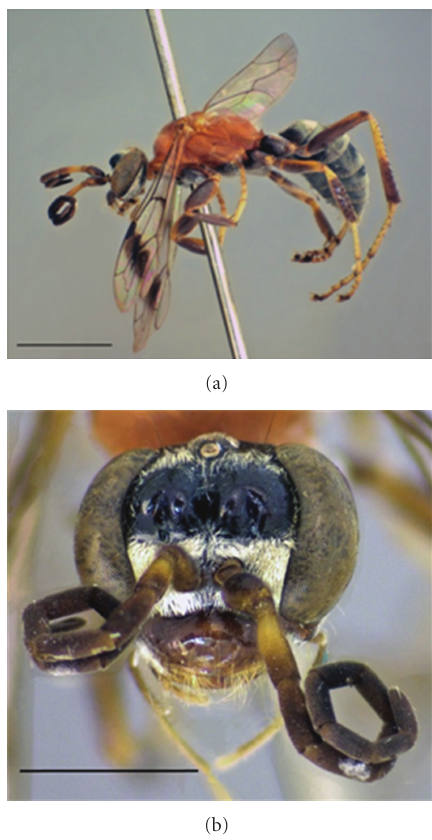
Figure 1: Neotype of Ageniella ( Neotumagenia ) amazonica . (a) Habitus, lateral view. Scale = 2.4 mm. (b) Head, frontal view. Scale = 1.29